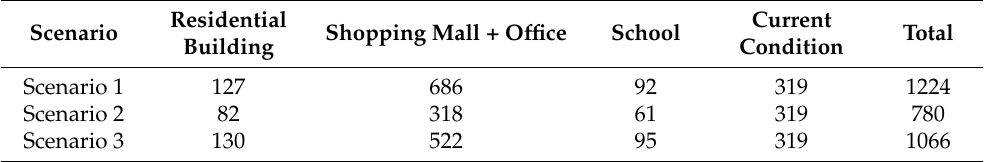
Table 8. Annual power consumption for Scenarios 1–3 (unit: GWh).